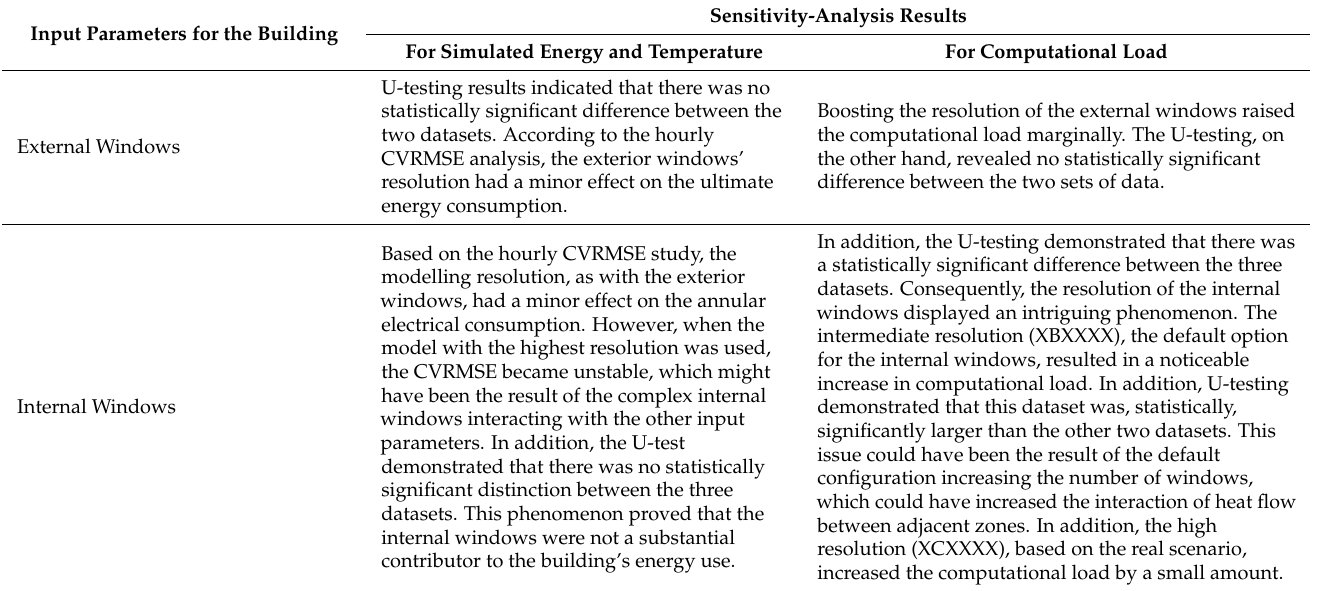
Table 8. Summary of sensitivity analysis of simulated energy and